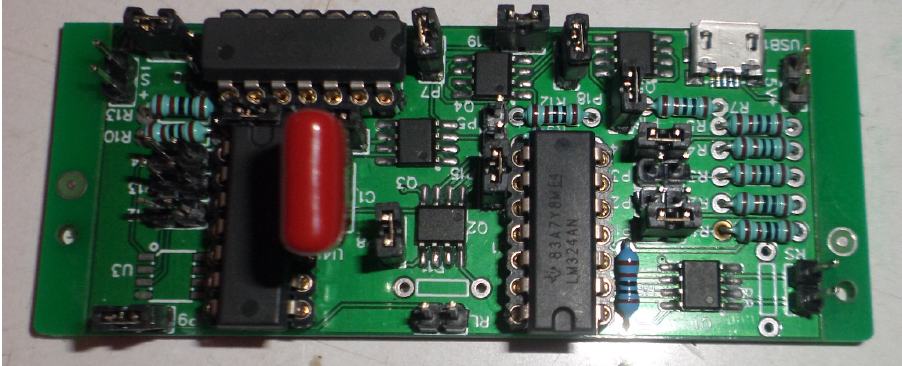
Figure 7. PCB from proposed circuit implementation.